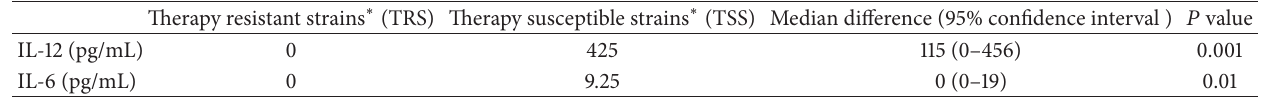
Table 3: Concentration of cytokines & in supernatant of THP-1 cells stimulated with different H. pylori antigens and with polymyxin B.